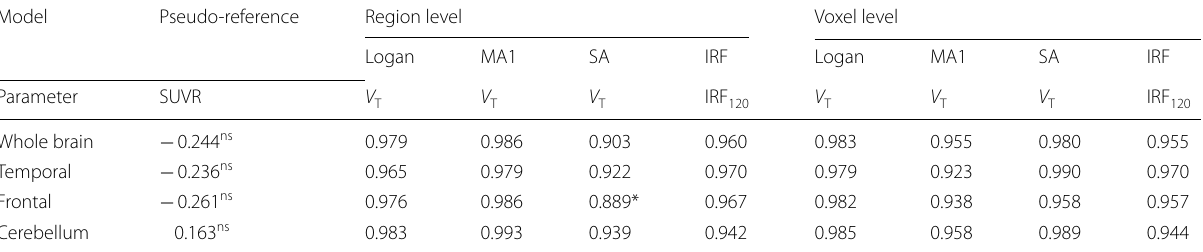
Table 1 Correlation (Pearson’s coefficient, r ) of different binding parameters with V compartment model in the representative regions